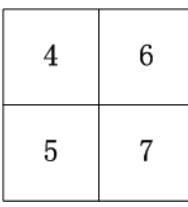
Table 3. The structure of tbl_task_execution